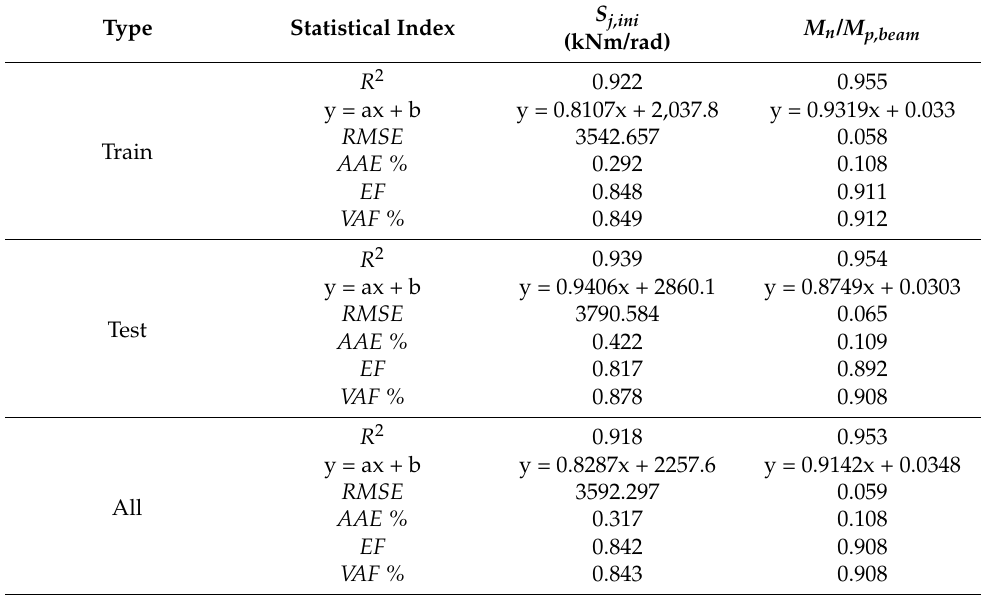
Table 3. Statistical indices of ANN with best 6-7-6-1 topology, as combined with artificial bee colony